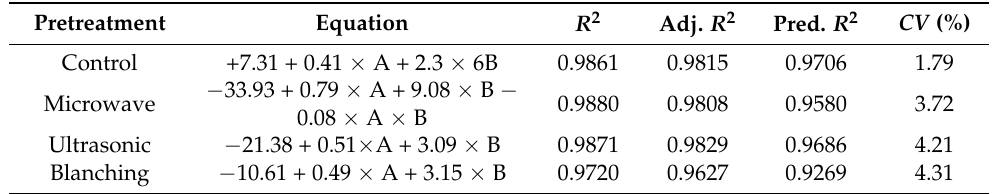
Table 7. RSM modeling for predicting color difference ( ∆ E ) of the samples dried under an HCIR dryer with different